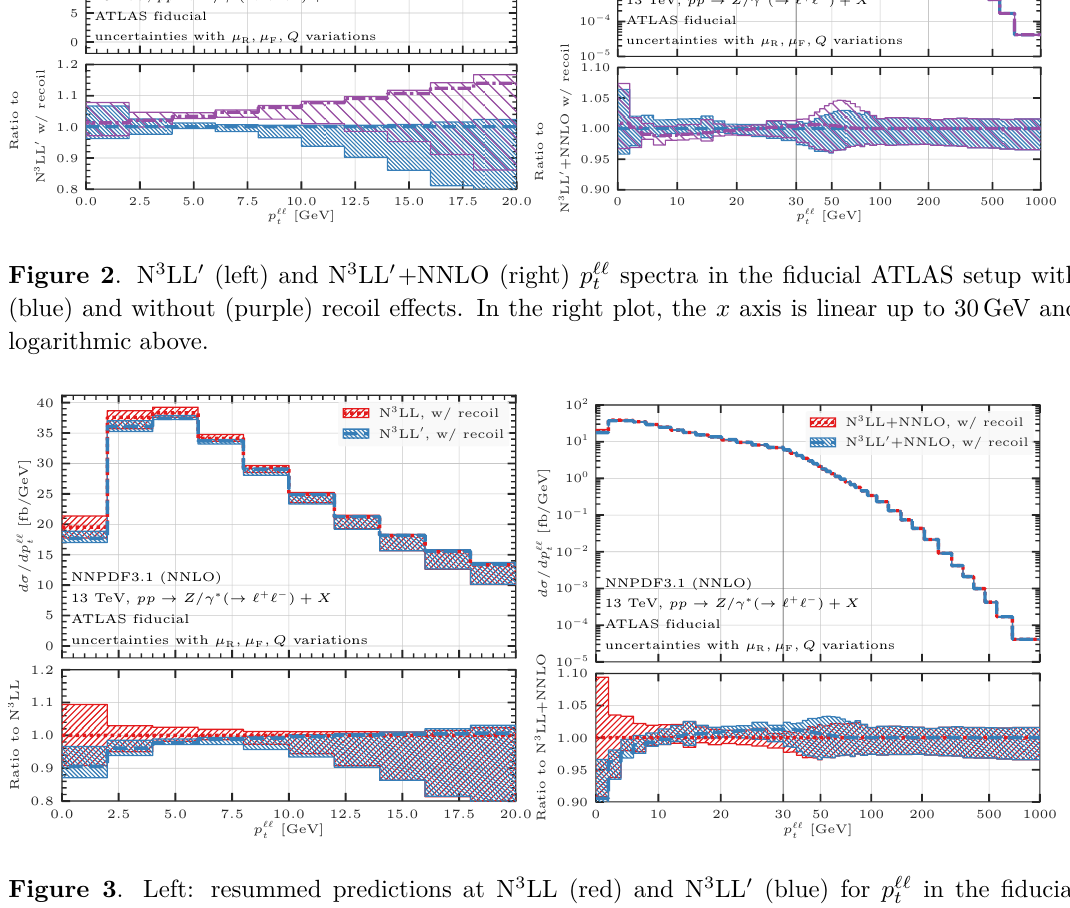
Figure 3 . Left: resummed predictions at N 3 LL (red) and N 3 LL 0 (blue) for p ‘‘ ATLAS setup. Right: matched prediction at N 3 LL +NNLO (red) and N 3 LL 0 +NNLO (blue). In the right plot, the x axis is linear up to 30 GeV and logarithmic